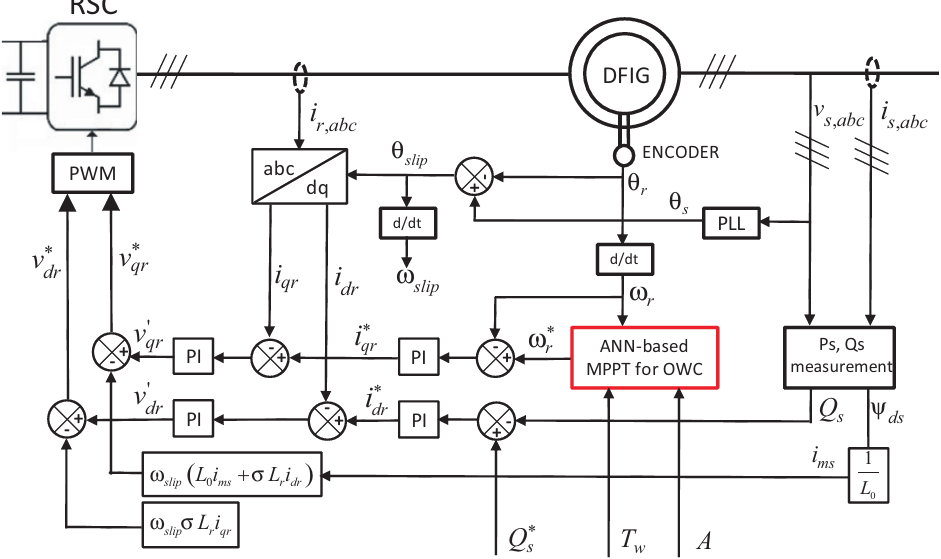
Figure 11. ANN-based rotor-side converter control